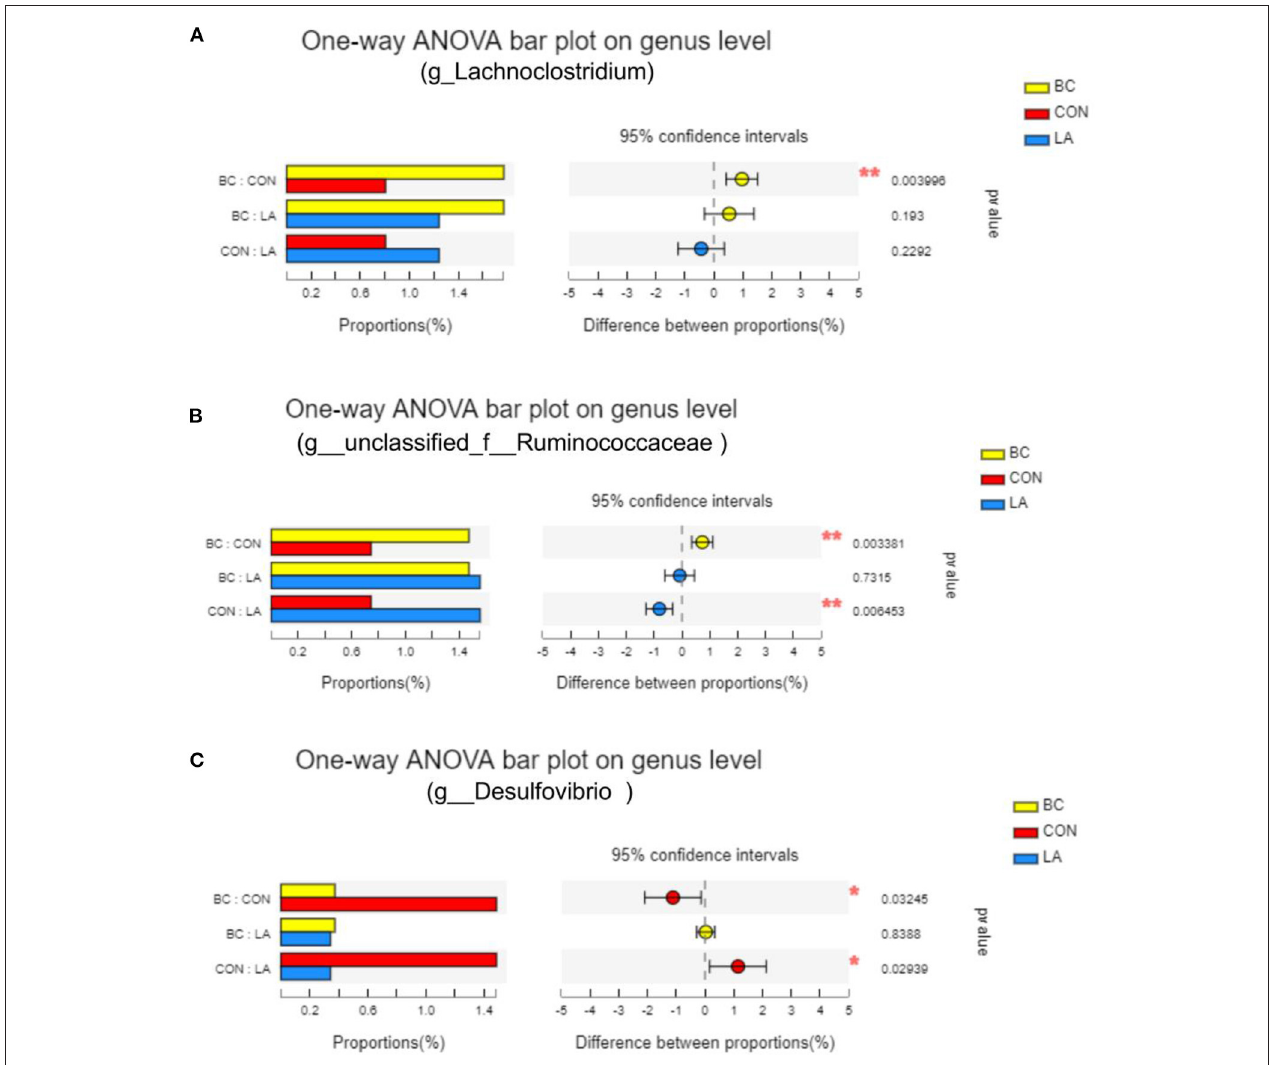
FIGURE 9 | Effects of probiotics on cecal species abundance of LPS-attacked broilers. (A–C) Were the test results of the significance of intergroup differences of Lachnoclostridium , Ruminococcaceae and Desulfovibrio , respectively, inspection methods: one-way ANOVA, correct ways: False discovery rate; CON, broilers were not treated except for the base diet; BC, broilers were supplemented with Bacillus coagulans ; LA, broilers were supplemented with Lactobacillus plantarum ; “*” means significantly difference. “ * ” means extremely distinct difference. N =